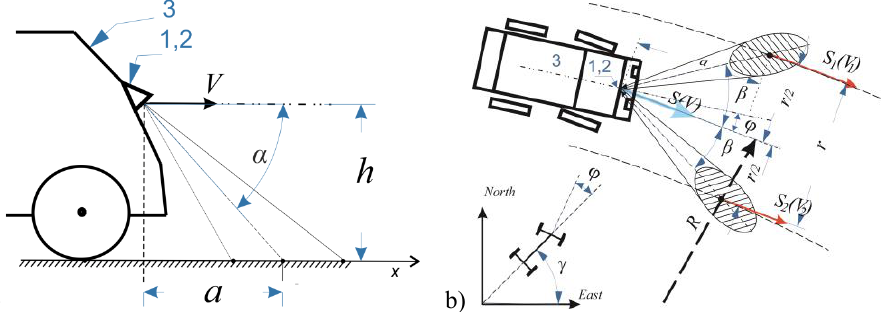
Fig. 1. The location of the antennas of Doppler sensors 1 and 2 on ground transport -3: a) - side view; b) - top